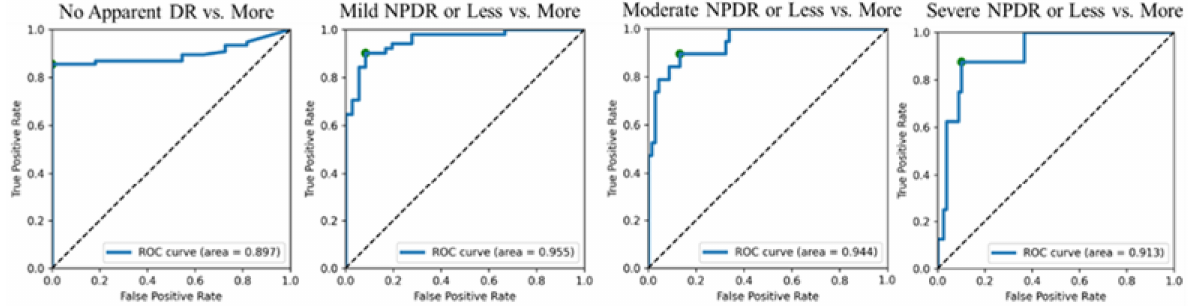
Figure 3. Receiver Operating Characteristic (ROC) curves of four threshold patterns in the SVM classification of the 87-eye dataset for building the SVM